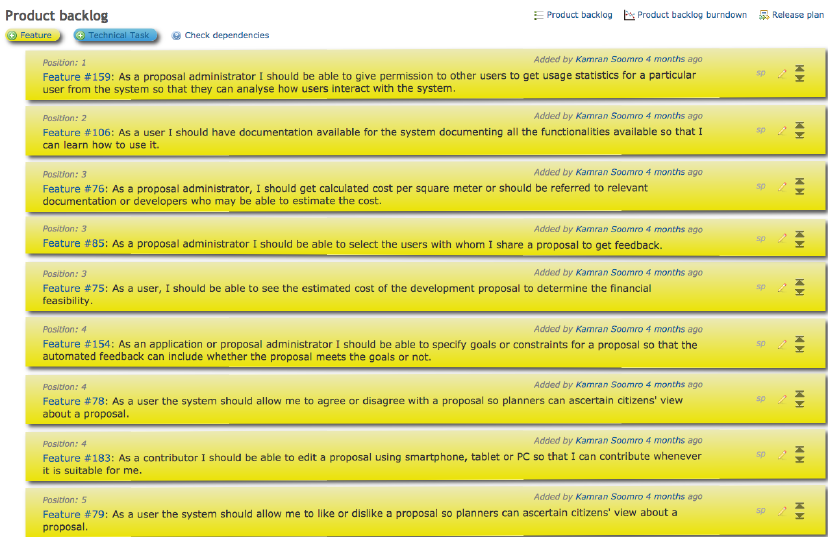
Figure 4. Product backlog—(total 117 features).